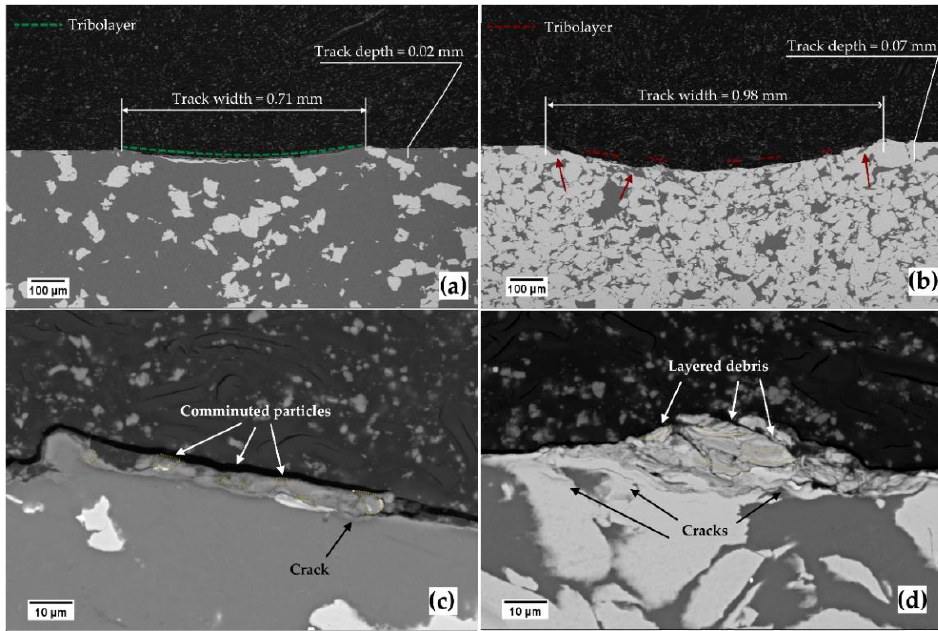
Figure 5. SEM cross-section micrographs of the wear tracks at increasing magnification. ( a , c ) for the Ti20 – AlSi sample, ( b , d ) for the Ti80 – AlSi sample.